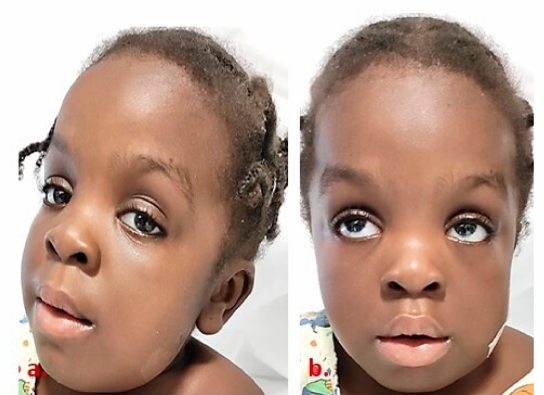
Figure 1. Pre-operative pictures. ( a ) Three-quarter view facing left; ( b ) frontal view. Hypertelorism and depressed nasal bridge, common features of Hurler syndrome, are clearly